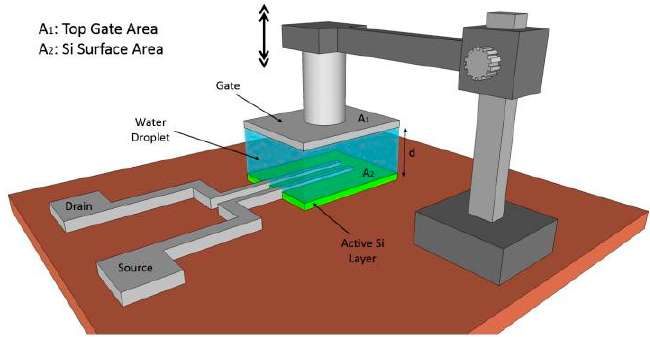
Figure 1. WG-FET with adjustable top gate electrode gap.